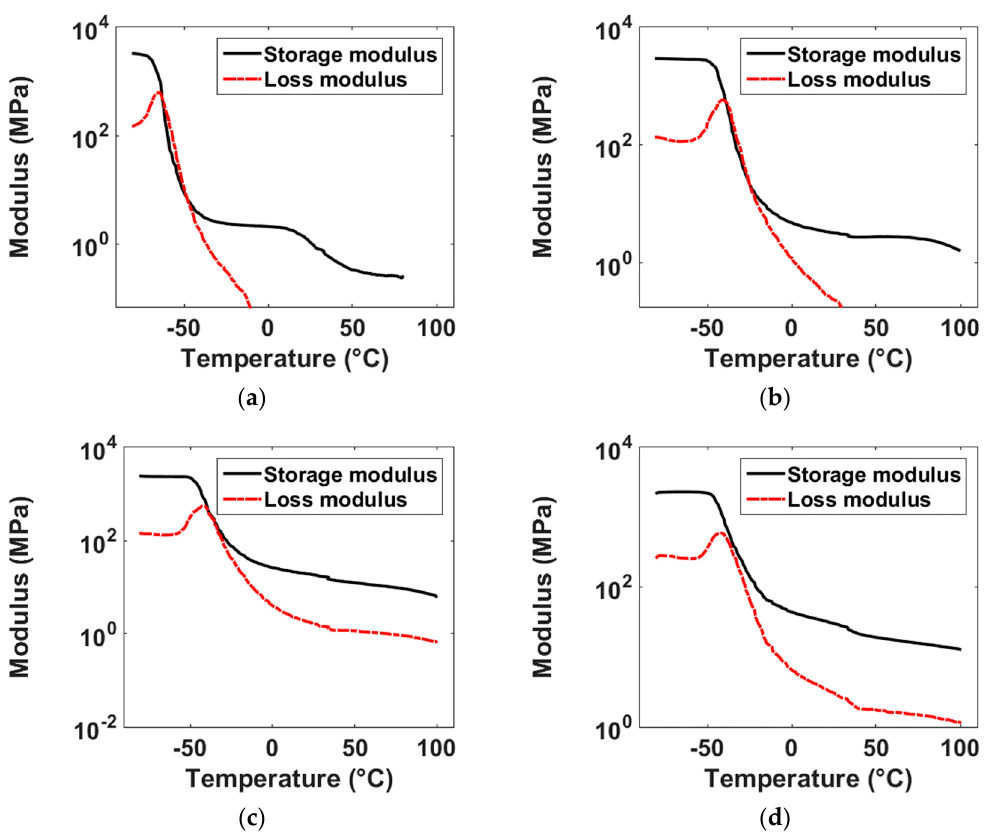
Figure 6. Cumulative plots of E’ and E” from − 80 °C to 100 °C. ( a ) VR00, ( b ) VR20, ( c ) VR40, ( d ) VR60.